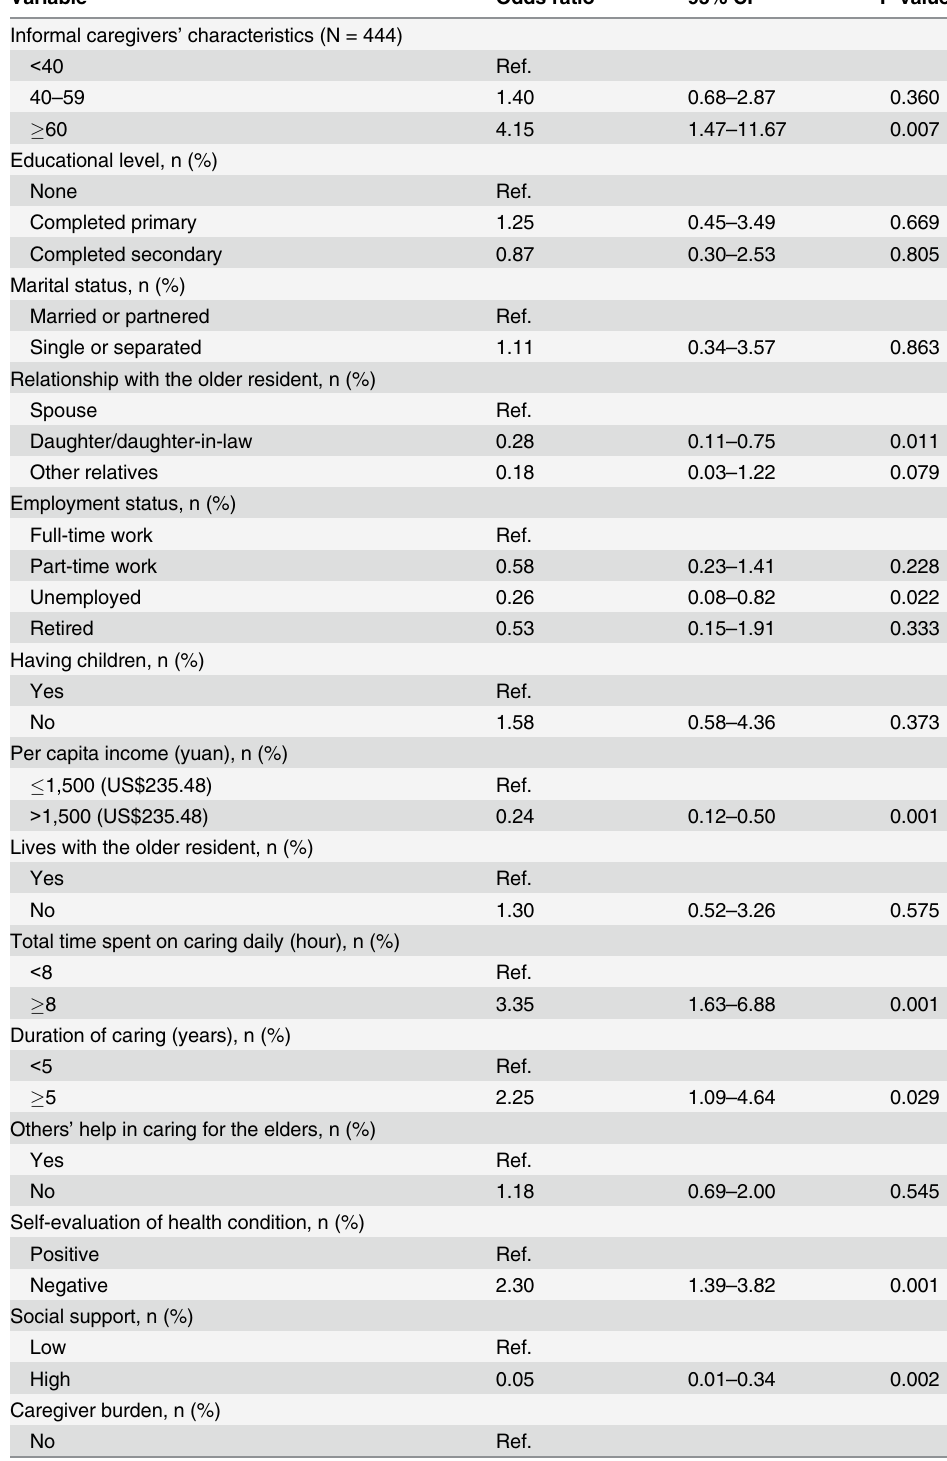
Table 3. Multivariate logistic regression analysis: Factors associated with the depressive emotion among the informal caregivers of disabled elders (N =